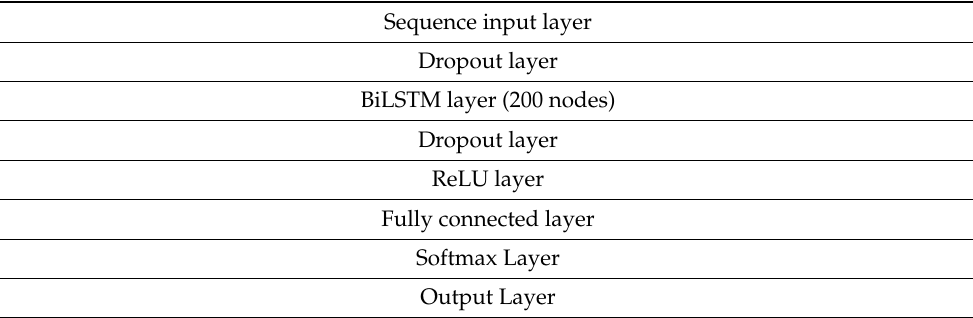
Table 1. Illustration of the bi-directional long term short term memory (BiLSTM) network topology used to classify the data in this work